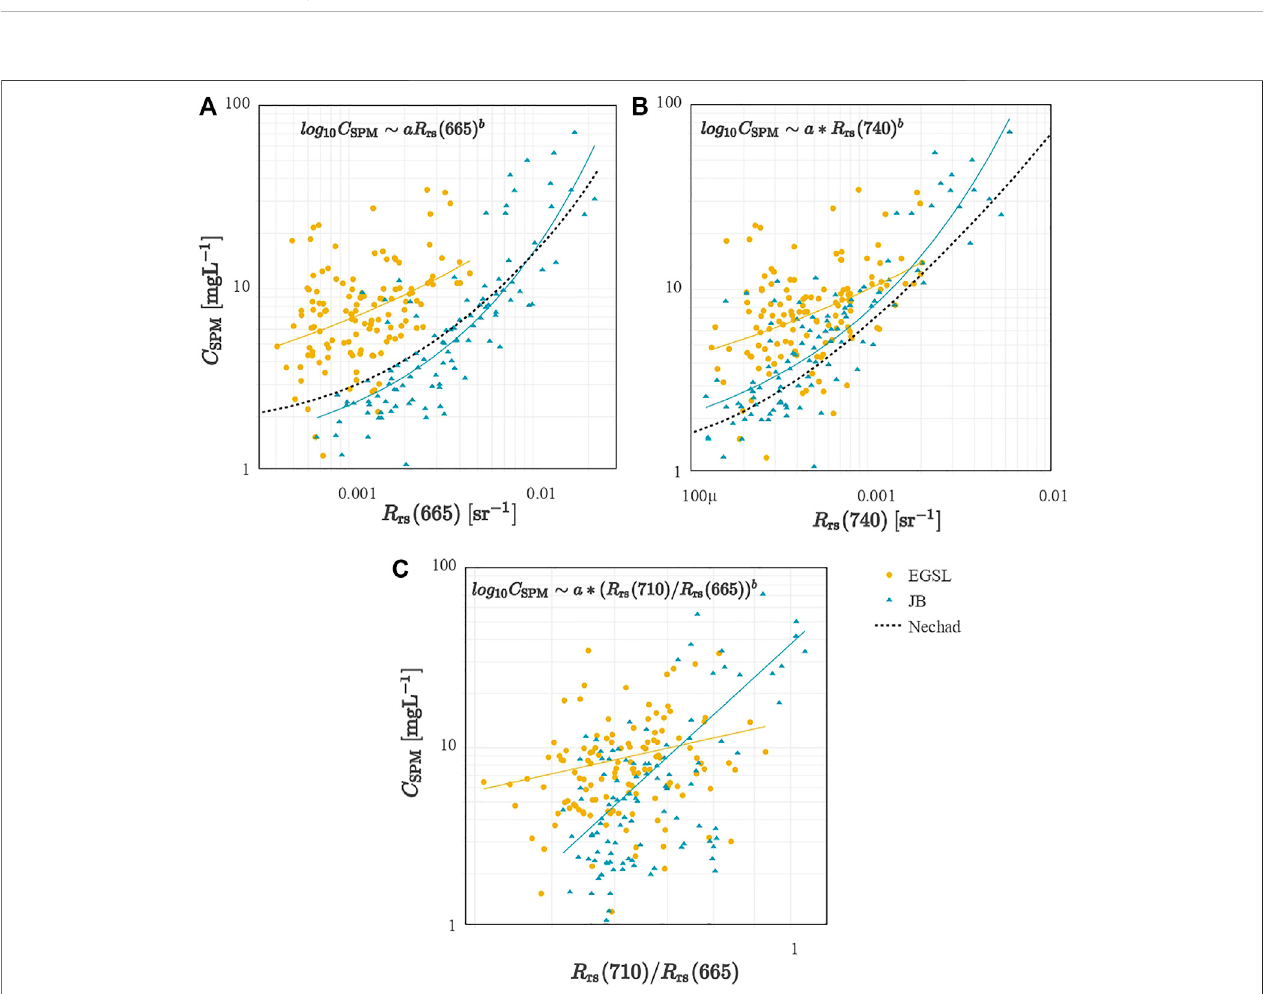
FIGURE 6 | Regional empirical algorithms for C SPM (A) from R rs (665) (B) from R rs (740), and (C) from R rs (710)/ R rs (665) ratio. Dashed line corresponds to C SPM values fi tted with Nechad et al. (2010) semi-empirical algorithm.